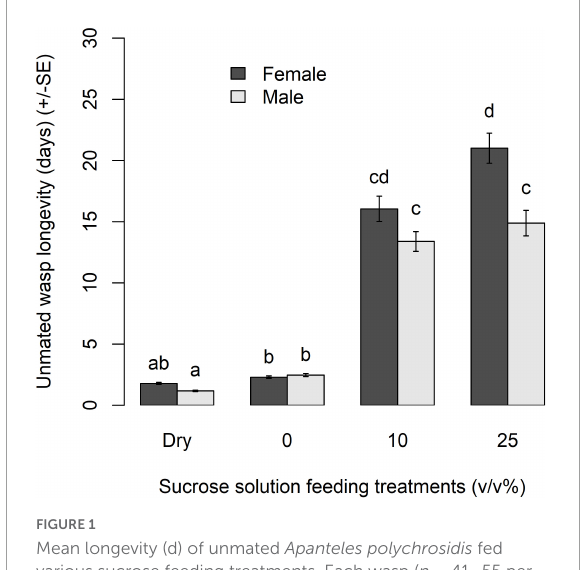
FIGURE2 Mean egg load at death of unmated female Apanteles polychrosidis . Each wasp ( n = 20–28) was provided with a feeding treatment of either 10 or 25% (v/v) sucrose in deionized water and a deionized water control (0), or a dry feeder control (Dry). Wasps were maintained at 21 ◦ C, and feeding treatments were changed every 5 days until death. Dead females were frozen at –20 ◦ C until dissection to count eggs. Bars marked with different letters are significantly different ( p < 0.05) [compact letter display (cld) of multiple pairwise